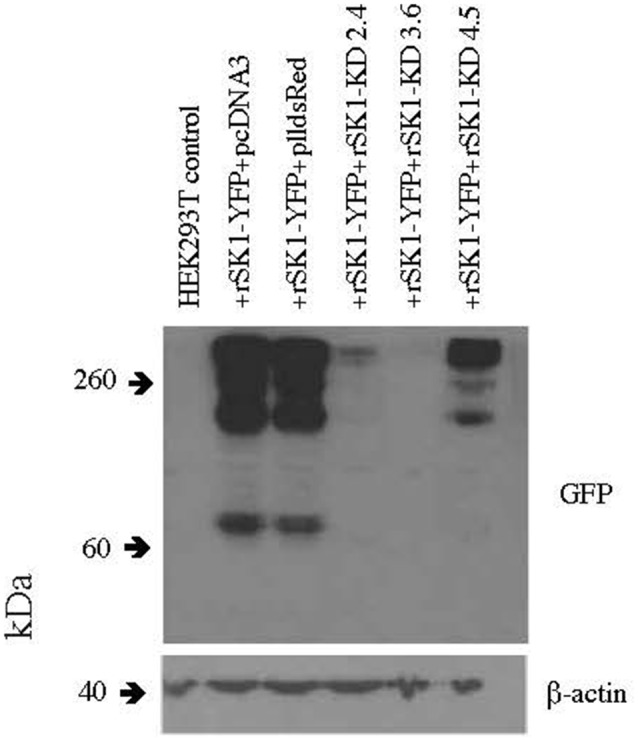
rSK1-KD 3.6 reduces rSK1-YFP expression in HEK293T cells. Western blot of total cell lysates of HEK293T cells transfected with rSK1-YFP and co-transfected with pcDNA3 or plldsRed or three different knock-down hairpin constructs: rSK1-KD 2.4 or rSK1-KD 3.6 or rSK1-KD 4.5. rSK1-KD 3.6 reduced the expression of rSK1-YFP by over 90% and was used in all further experiments. β-actin was used as a loading control.